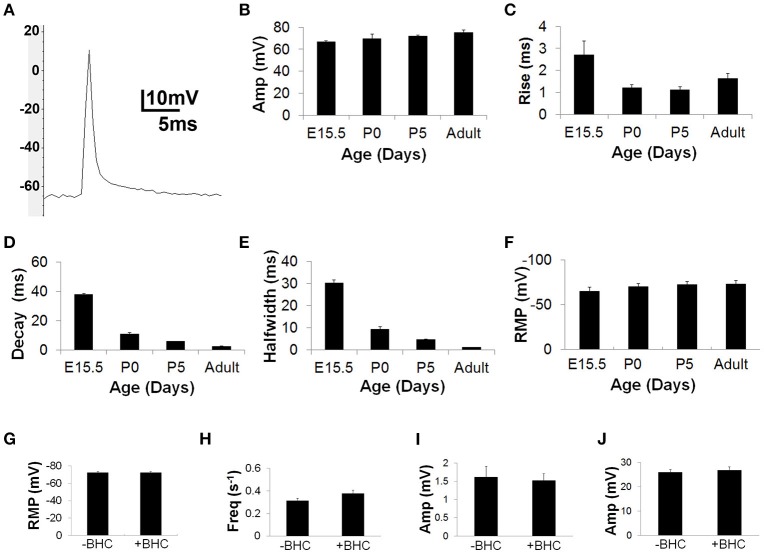
BHC permits the measurement of nerve-evoked muscle action potentials (APs). (A) Representative image of an AP recorded in the presence of 50 μM BHC with a sharp intracellular electrode from the motor endplate of an adult mouse diaphragm muscle fiber in response to a single suprathreshold square wave phrenic nerve impulse. Note overshoot. Average amplitudes are lower (E15.5 AP amp = 65.5 ± 1.6 vs. adult AP amp = 75.3 ± 2.2 mV; P < 0.001; n = 55 from 10 mice; B), and 10–90% rise-to-peak (E15.5 R2P = 2.7 ± 0.7 vs. adult R2P = 1.6 ± 0.2 ms; P < 0.001; n = 55 from 10 mice; C), 100–50% decay (E15.5 T2D = 37.8 ± 1.6 vs. adult T2D = 2.4 ± 0.2 ms; P < 0.001; n = 55 from 10 mice; D), and 50–50% halfwidth (E15.5 HW = 30.2 ± 2.7 vs. adult HW = 1.2 ± 0.1 ms; P < 0.001; n = 55 from 10 mice; E) of muscle APs are significantly longer at E15.5 (E15.5) than postnatal stages. (F) Average resting membrane potential (RMP) is less negative at E15.5 vs. postnatal ages (E15.5 RMP = −64.8 ± 4.3 vs. adult RMP = −70 ± 2.6 mV; P < 0.05; n = 5 from three mice; F). The RMP is similar in the presence or absence of 10 μm BHC in the adult; (−72.4 ± 2.3 vs. −72.2 ± 3.6 mV; P = 0.46; n = 5 from three mice; G). The frequency of miniature endplate potentials (mEPPs; 0.27 ± 0.04 vs. 0.38 ± 0.03 mEPPs/s; P = 0.06; 10 s analyzed; n = 8 from five mice; H), as well as the amplitude of mEPPs (1.6 ± 0.3 vs. 1.5 ± 0.2 mV; P = 0.1; n = 22 from five mice; I) and EPPs (26.2 ± 1.1 vs. 26.7 ± 1.3 mV; P = 0.06; n = 22 from five mice; J) are similar in the presence or absence of BHC in the adult. All values expressed in means ±SD.